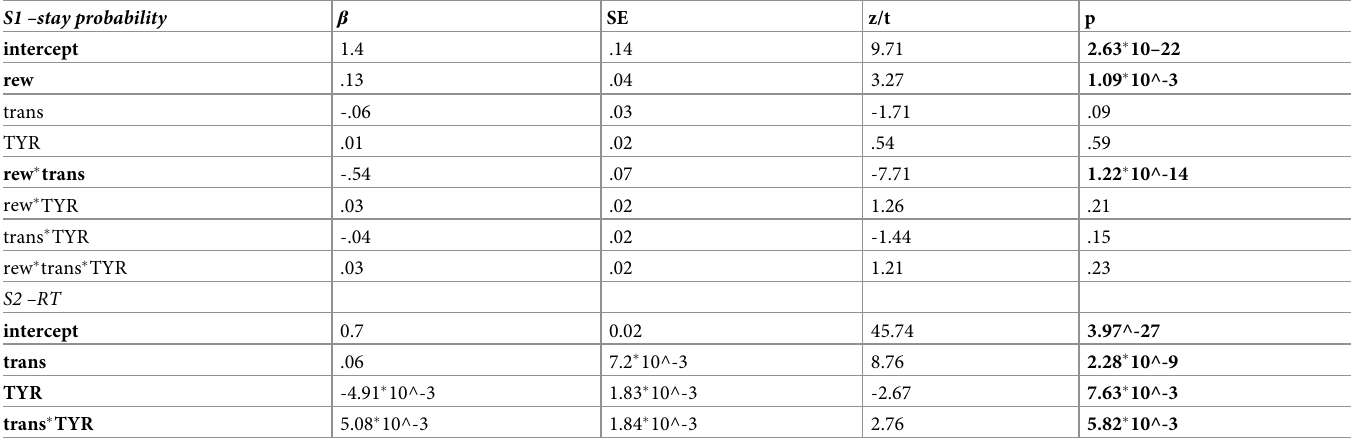
Table 2. Effects on participants’ (N = 28) probability to choose the same option in S1 as in the previous trial from a generalized mixed effects regression (glmer) analysis (rew = reward; trans = state transition; TYR = tyrosine; glmer model: stay(S1) ~ rew � trans � TYR + (rew � trans + 1 | participant)). And effects of state transi- tion (trans), TYR vs. placebo (TYR) supplementation and their interaction on participants S2 RTs from a lmer analysis (lmer model: RT(S2) ~ trans � TYR + (trans + 1 | participant). S1 –stay